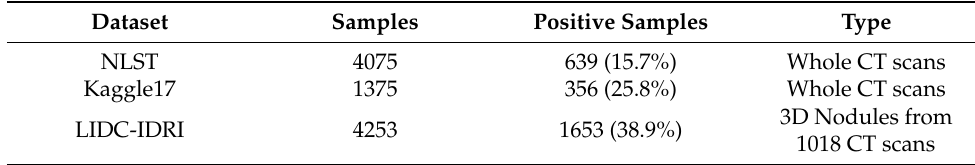
Table 1. Summary of